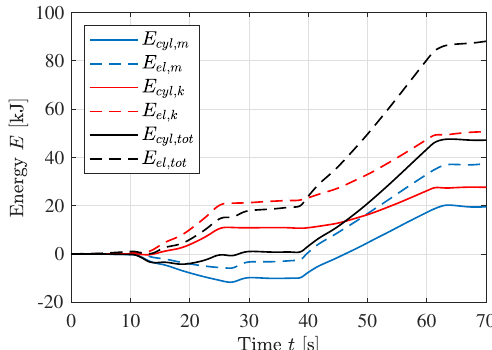
Figure 34. Energy consumed during motion.